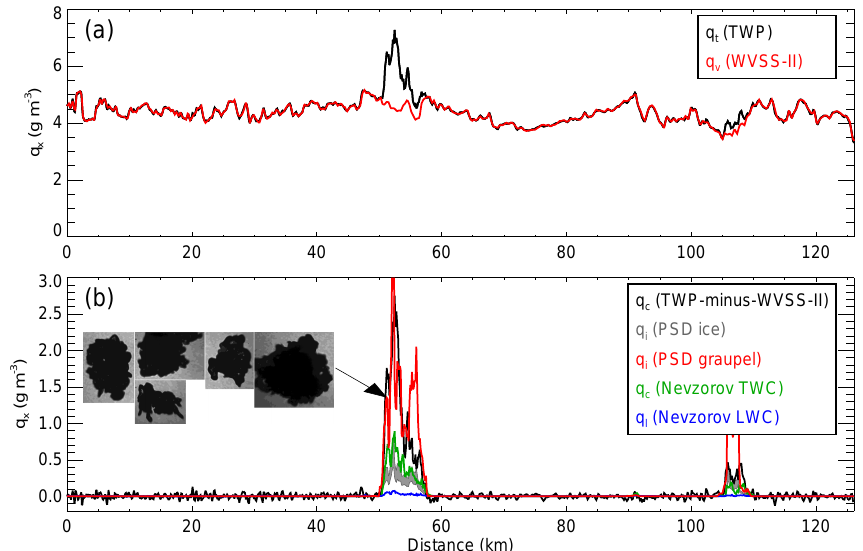
Figure 3. As Fig. 2 but showing measurements in precipitation at cloud base made during flight B667 at a temperature of − 1.3 ◦